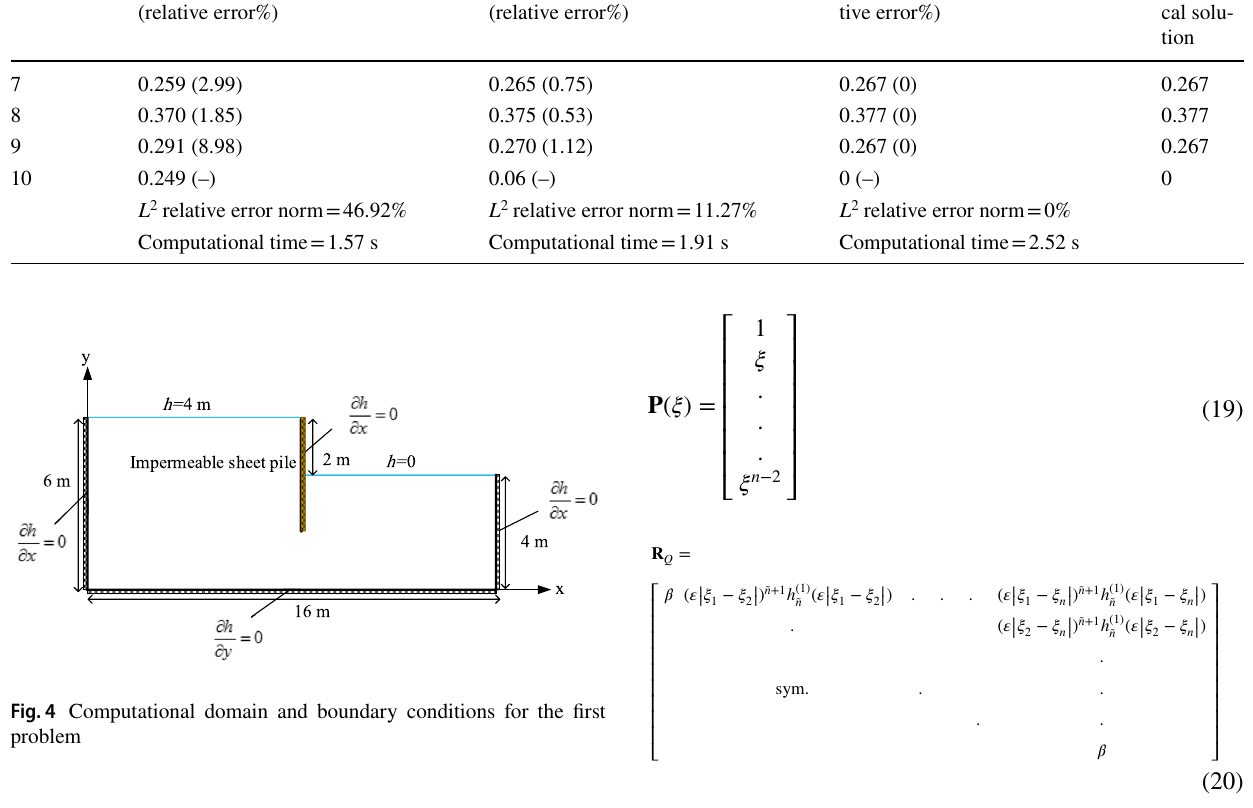
Hankel shape function (8 elements) (relative error%)